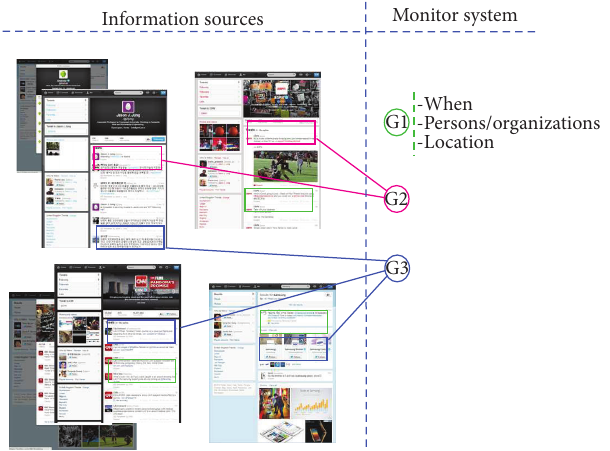
Figure 1: Example about demand to monitor and aggregate infor- mation.